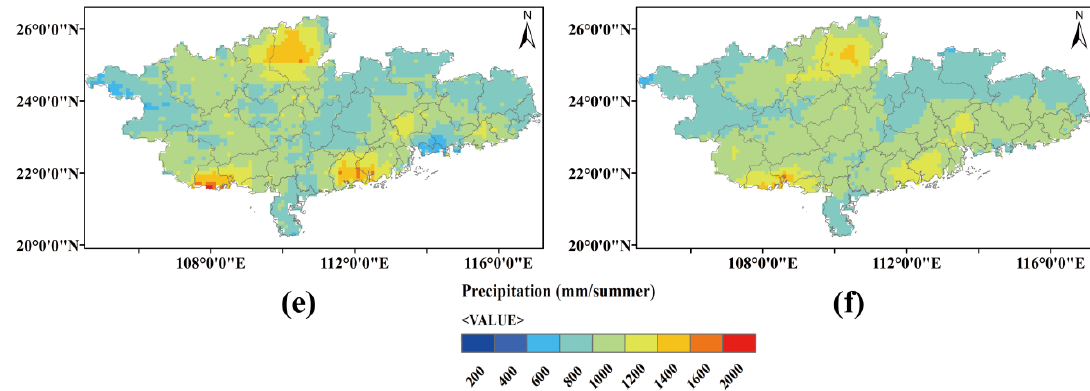
Figure 2. Spatial patterns of accumulated rainfall estimated by ( a ) China Merged Precipitation Analysis (CMPA), ( b ) Precipitation Estimates from Remotely Sensed Information using Artificial Neural Networks Cloud Classification System (PERSIANN-CCS), ( c ) European Center for Medium-Range Weather Forecasts Reanalysis v5 (ERA5-Land), ( d ) Fengyun-4 (FY-4A), ( e ) Global Satellite Mapping of Precipitation (GSMaP) (GSMaP), and ( f ) Multi-satellitE Retrievals for Global Precipitation Measurement (IMERG) over southern China in summer 2019.